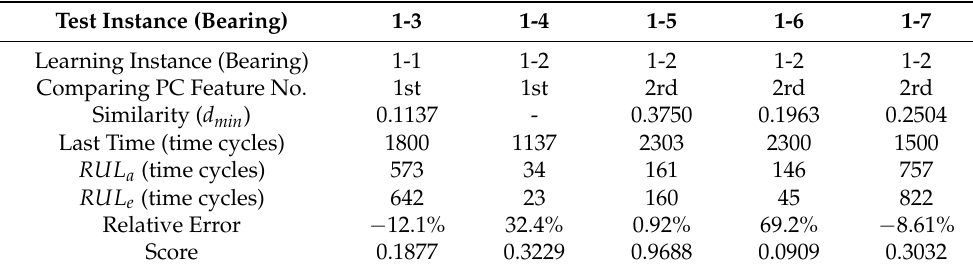
Table 6. Summary of RUL estimation results for Bearing1-3, 1-4, 1-5, 1-6, and 1-7.